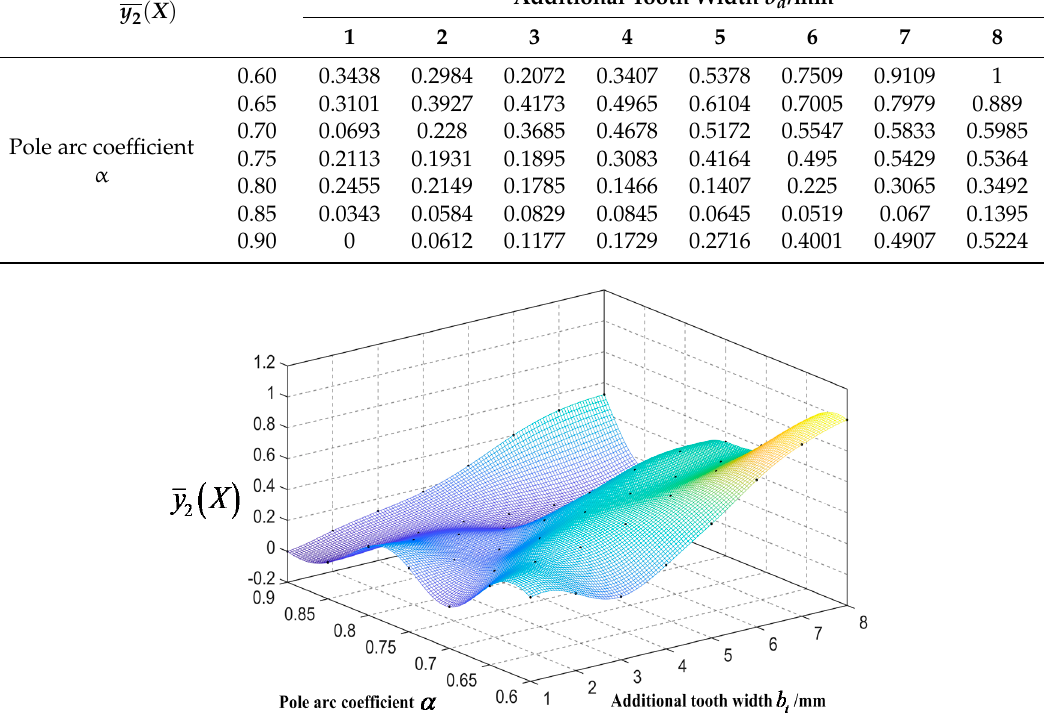
Figure 17. Response surface of sub objective function (cid:98) y 2 ( X ) .